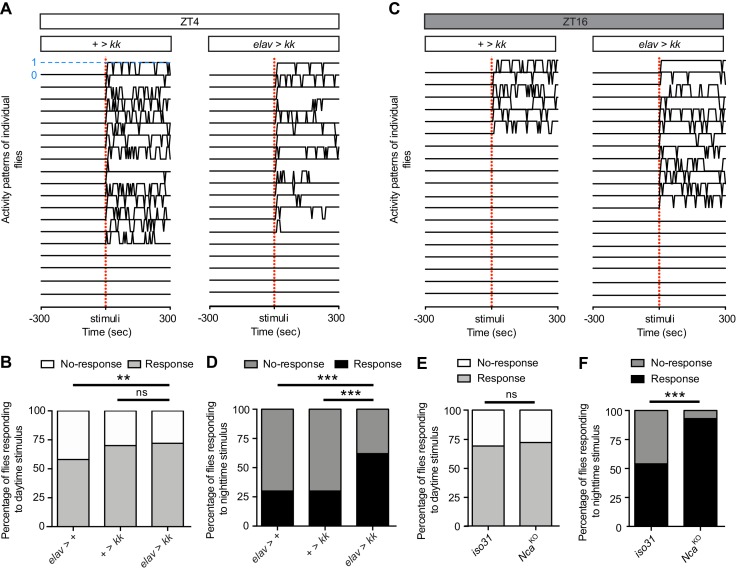
NCA reduces responsiveness to stimuli at night under 8L: 16D conditions.(A, C) Locomotor activity in twenty representative control (+ > kk) and NcaKD (elav > kk) adult male flies at either ZT4 (A) or ZT16 (C), as measured using the DART system. X-axis denotes 300 s before and after a vibration stimulus (red dotted line). Y-axis represents movement of individual flies in a binary manner (1 = movement, marked by blue dotted line for one fly; 0 = immobility). Only flies that were immobile for five mins preceding the stimulus were selected for analysis. (B, D) Percentage of NcaKD and control flies responding or not responding to vibration stimulus at either ZT4 (B) or ZT16 (D). ZT4: elav > +: n = 24, + > kk: n = 33, elav > kk: n = 33. ZT16: elav > +: n = 23, + > kk: n = 30, elav > kk: n = 29. (E, F) Percentage of NcaKO and iso31 control flies responding or not responding to vibration stimulus at either ZT4 (E) or ZT16 (F). ZT4: iso31: n = 48, NcaKO: n = 53. ZT16: iso31: n = 48, NcaKO: n = 44. ns – p>0.05, **p<0.01, ***p<0.001, Binomial test with Bonferonni correction for multiple comparisons.10.7554/eLife.38114.013Figure 2—source data 1.Proportion of Nca knockdown and knockout flies responding to mechanical stimuli.